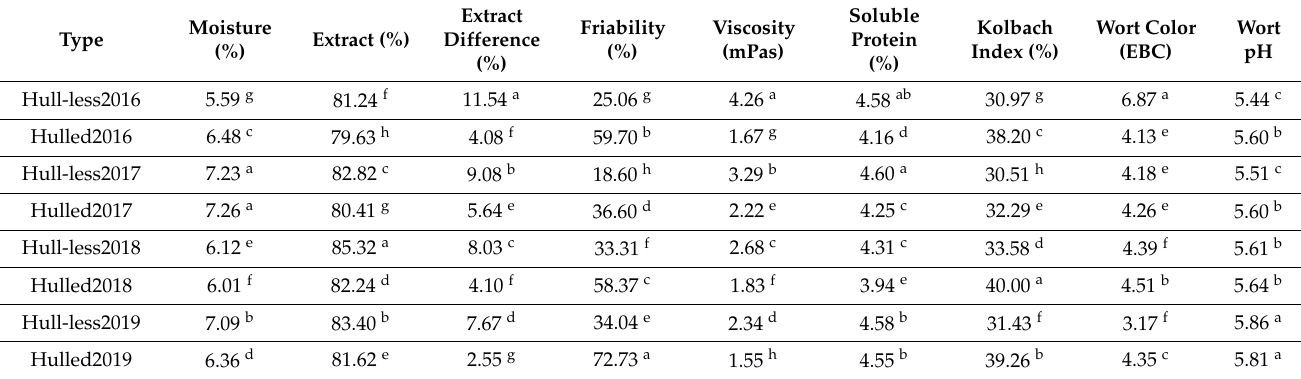
Table 4. Mean values malt quality indicators for each